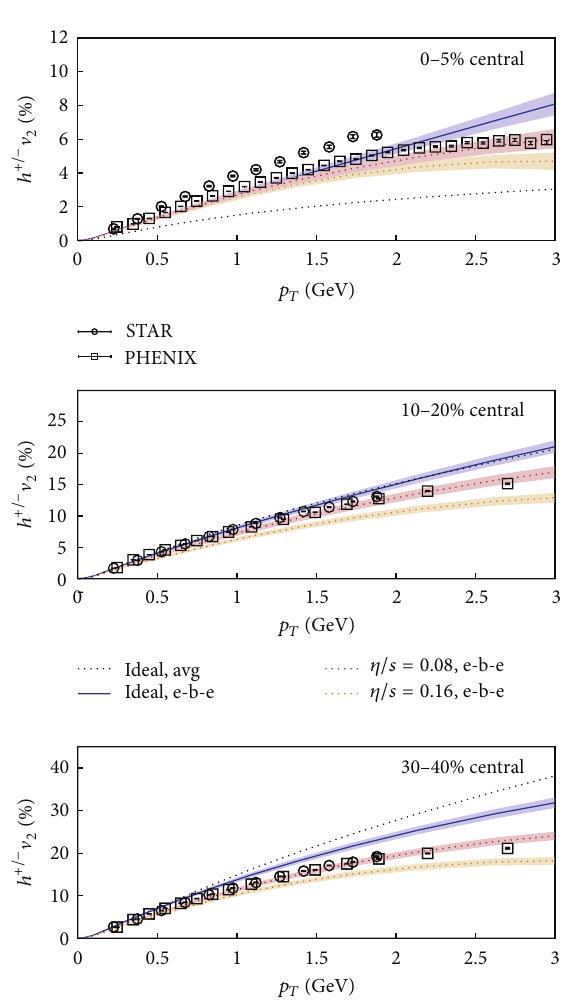
Figure 16: Charged hadron elliptic flow ( V 2 ) for different centralities as a function of transverse momentum for averaged initial condi- tions (avg) and event-by-event simulations (e-b-e) using different viscosity to entropy density ratios compared to STAR [33] and PHENIX [34] data. The figures are from [92].